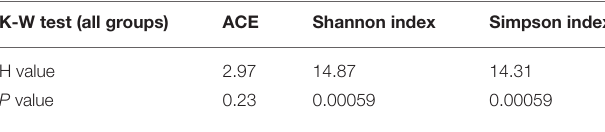
TABLE 2 | Kruskal-Wallis tests of Alpha diversity in three groups of